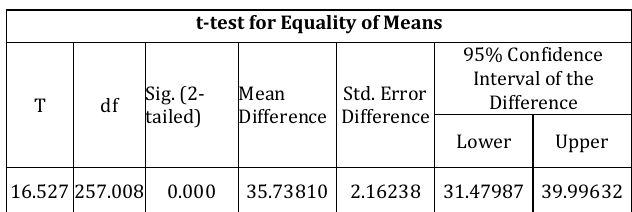
Table 5: Comparison of traffic Density in both sites (Site-1 Canal Park and Site-2 Gat Wala Park) t-test for Equality of Means